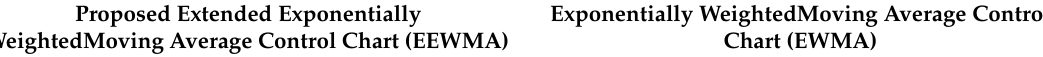
Table 8. Simulated Table 8. Simulated data.